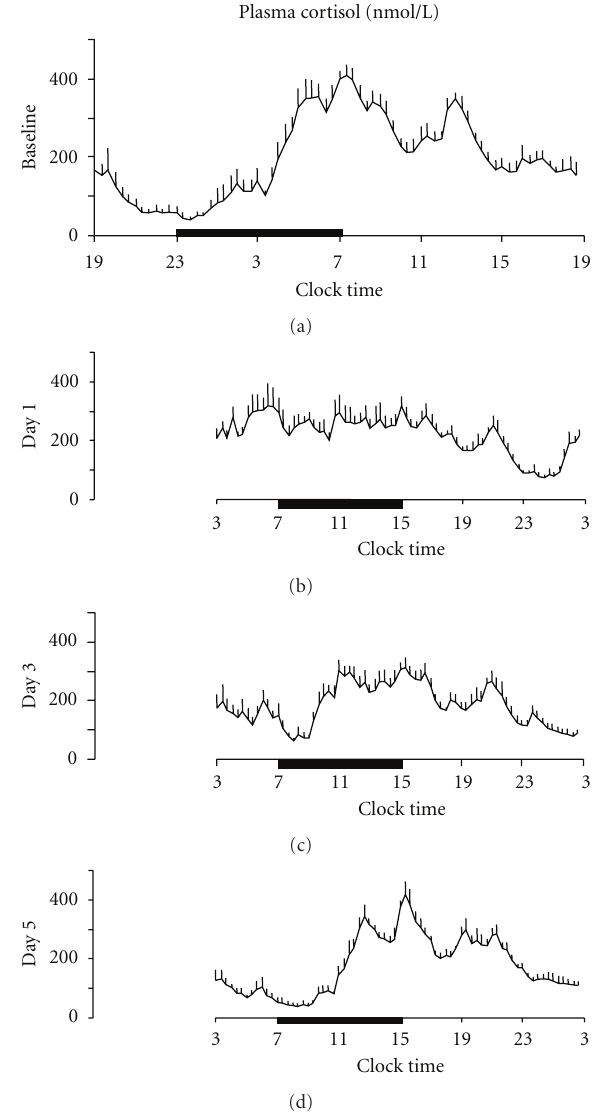
Figure 3: E ff ect of an 8-hour sleep delay on cortisol profiles. Mean 24-hour (+ SEM) cortisol profiles under baseline conditions (bedtimes from 23:00 to 7:00), and one, three, five days after an 8- hour delay of the sleep-wake and dark-light cycles (bedtimes from 7:00 to 15:00). Black bars represent the sleep periods. (Adapted from Buxton et al. [67].)